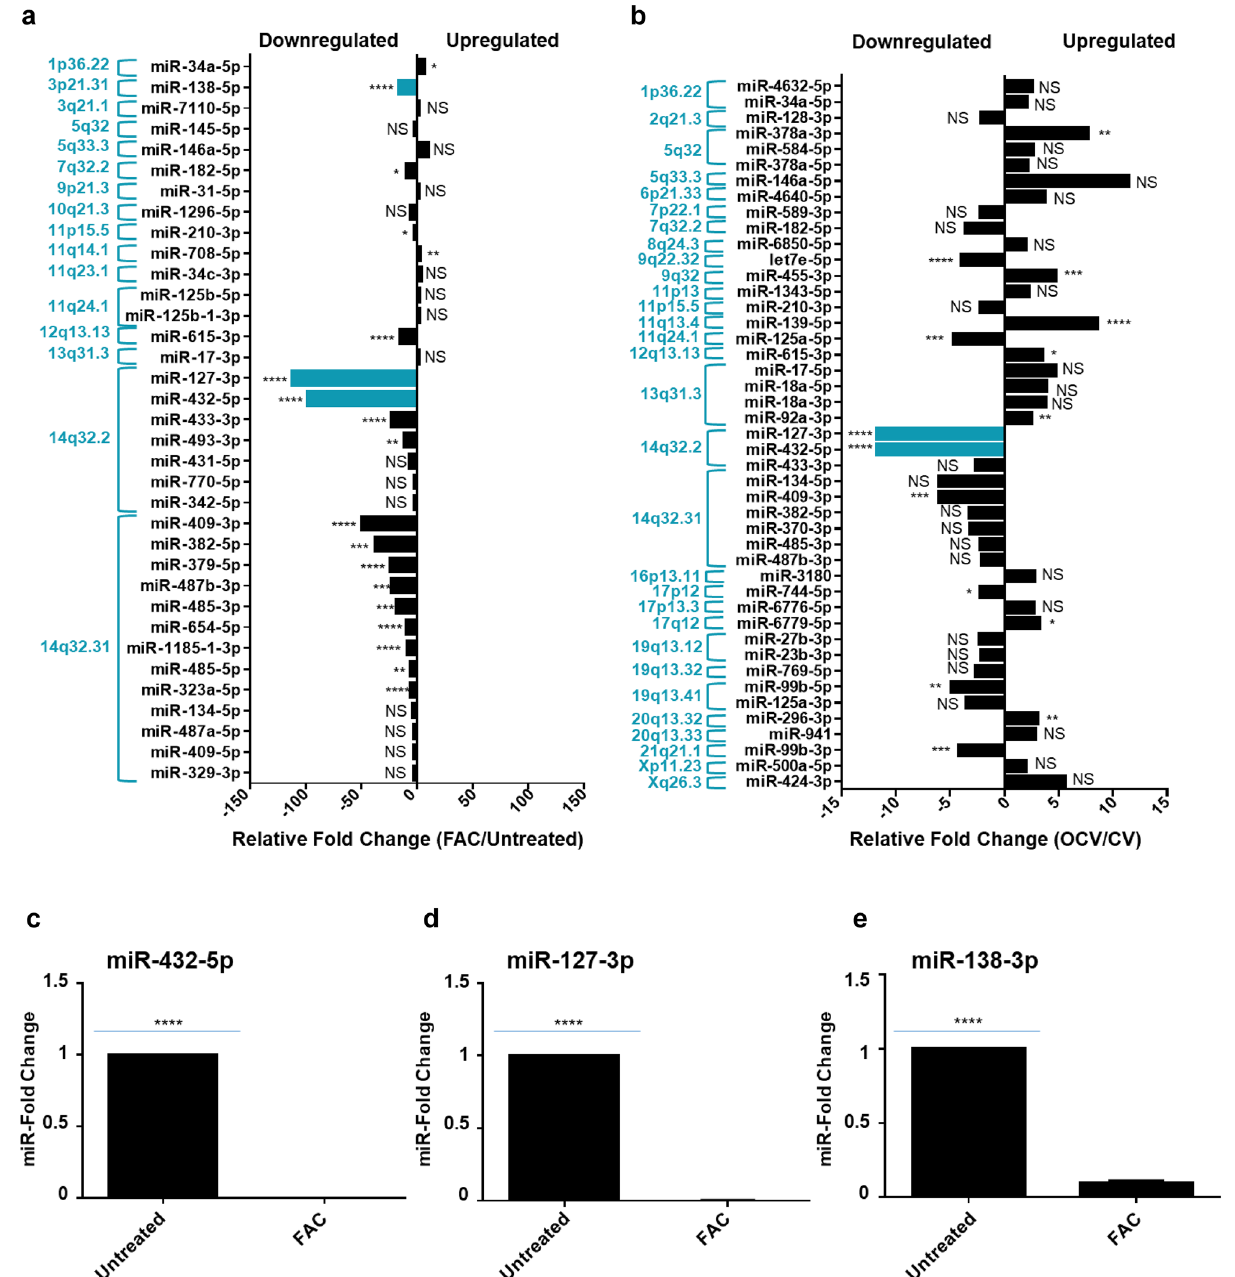
Figure 3. Top miRNAs altered in FT194 cells and their genomic locations. These graphs show the miRNA targets (analyzed via microarray profiling) which correlate with the protein changes (analyzed via mass spec proteomics analysis) as predicted by IPA. The relative fold change of miRNAs is represented and organized according to their genomic locations in ( a ) 250 nM FAC-treated FT194 cells compared to Untreated, and ( b ) FT194 transformed cells via Oncogenic cocktail virus (OCV), compared to control virus (CV) cells. Real- time PCR analysis of ( c ) miR-432-5p, ( d ) miR-127-3p, and ( e ) miR-138-5p was performed after isolating total miRNAs from 250 nM FAC-treated cells as compared to the Untreated, at days 111 and 124 of FAC treatment ( p = 33 and 37), to validate the downregulation of these miRNAs as predicted by IPA analysis. RNU6B was used as a reference control and the data represents composite of three independent